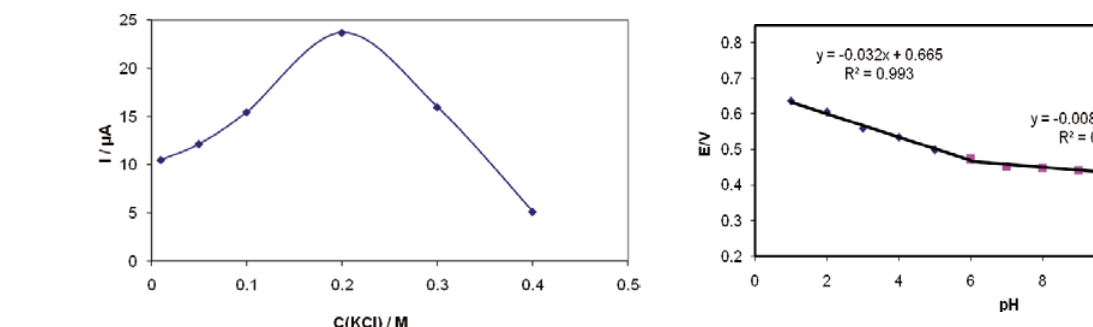
Figure 2. Anodic currents of ZMCCE at pH=7 versus various concentration of supporting electrolyte KCl, from 0.01 to 0.4 M. Concentration of Piroxicam is 9.9×10 -6 M.